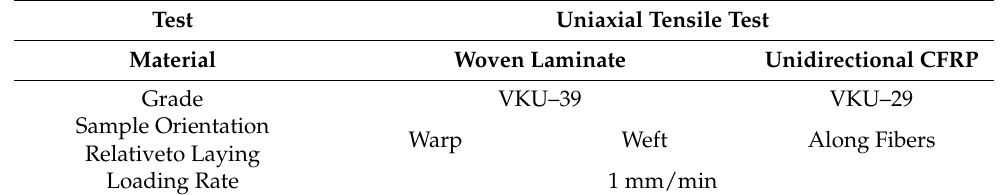
Table 1. Tested samples and loading parameters.